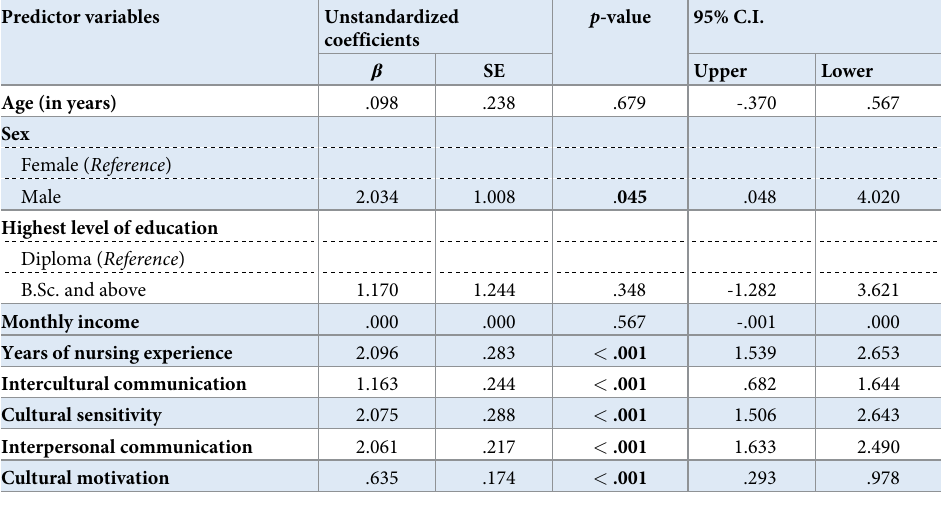
Table 3. Multivariable linear regression results showing factors associated with transcultural self-efficacy among nurses working at JMC, Oromia Region, Ethiopia, May to June 2020 (n =